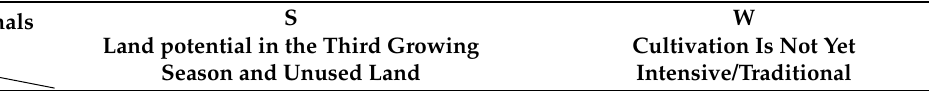
Table 8. SWOT strategy formulation for sorghum development in Gunungkidul Yogyakarta,